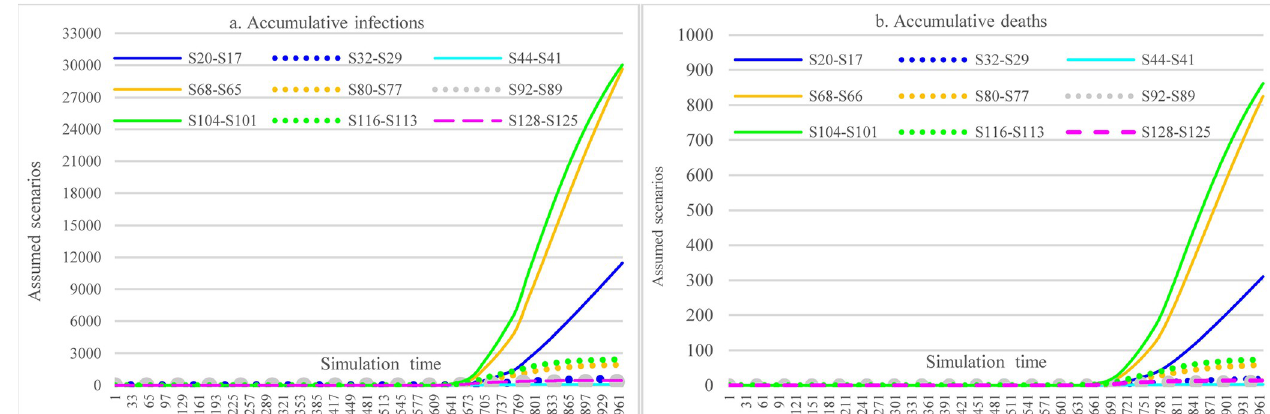
Fig 14. Impacts of immunological period and vaccine efficacy on COVID-19 considering mask-wearing adherence and increasing vaccination capacity.